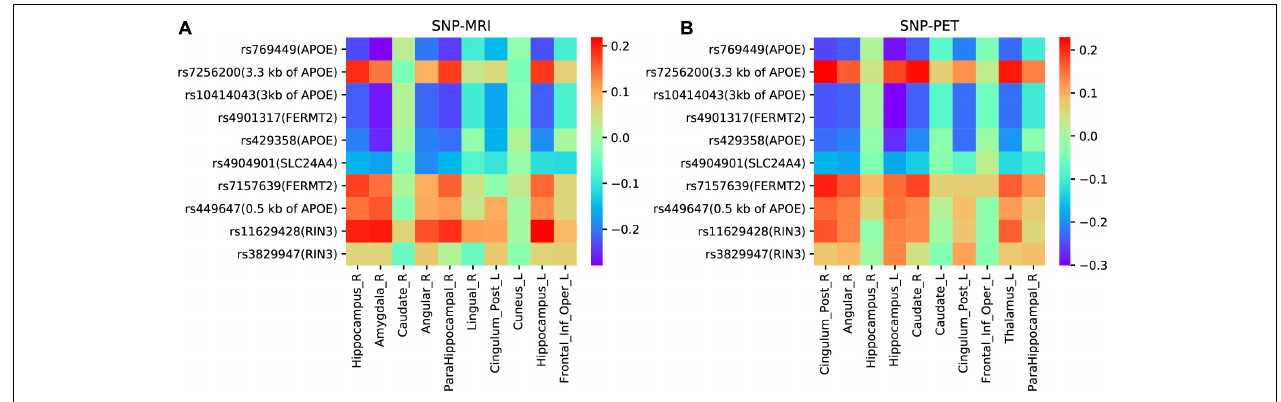
FIGURE 8 | (A) The heatmap of pairwise correlations between SNPs and ROIs of MRI scan. (B) The heatmap of pairwise correlations between SNPs and ROIs of PET scan.